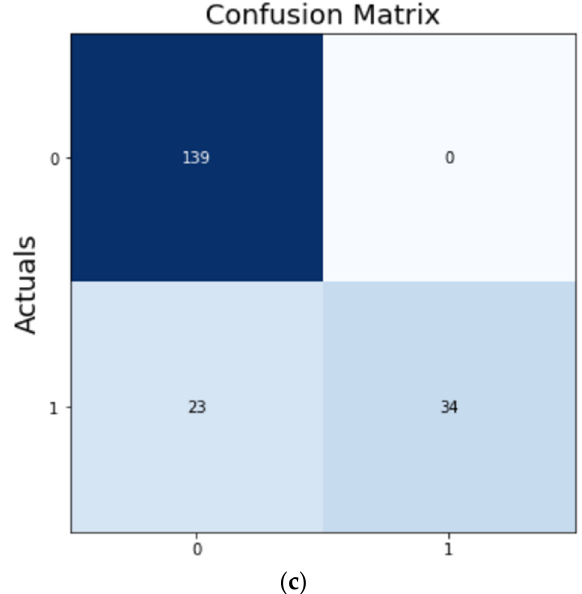
Figure 16. ( a ) Training loss curve, ( b ) validation loss curve, and ( c ) confusion matrix of validation data. Table 3. Accuracy metric readings of InceptionV3.